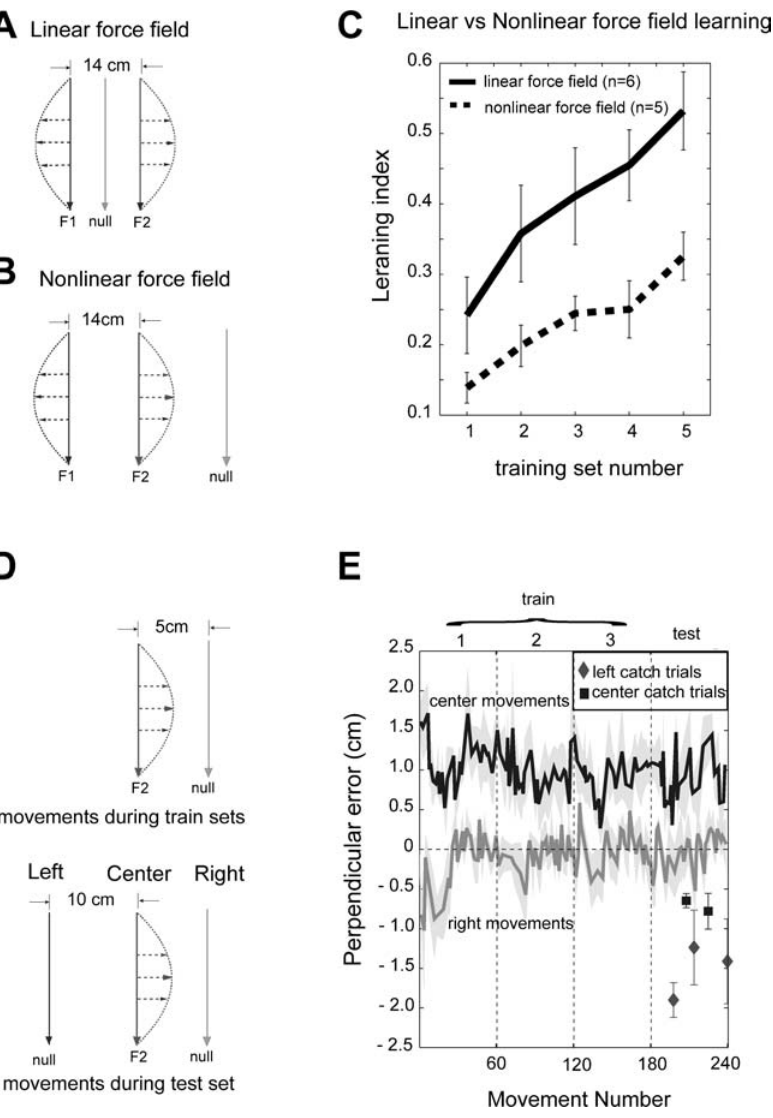
Figure 5. Predictions of the Gain-Field Encoding and Experimental Verification (A) A field where forces are linearly dependent on both limb position and velocity. (B) A field where forces are linearly dependent on limb velocity but nonlinearly dependent on limb position. Gain-field encoding predicts that the field in (B) will be harder to learn than one in (A). (C) Learning index of subjects ( n ¼ 6) for the paradigm in (A) and subjects ( n ¼ 5) for the paradigm in (B). (D) Gain-field encoding predicts hypergeneralization. The figure shows movements and its associated force field during training and test sets. (E) Performance of subjects ( n ¼ 4) for the paradigm in (D). Dark lines are errors in center movements and gray lines are errors in right movements. The shaded areas represent the SEM. Filled diamonds show the catch trials for the left movements during test set; filled squares show the catch trials for center movements. DOI: